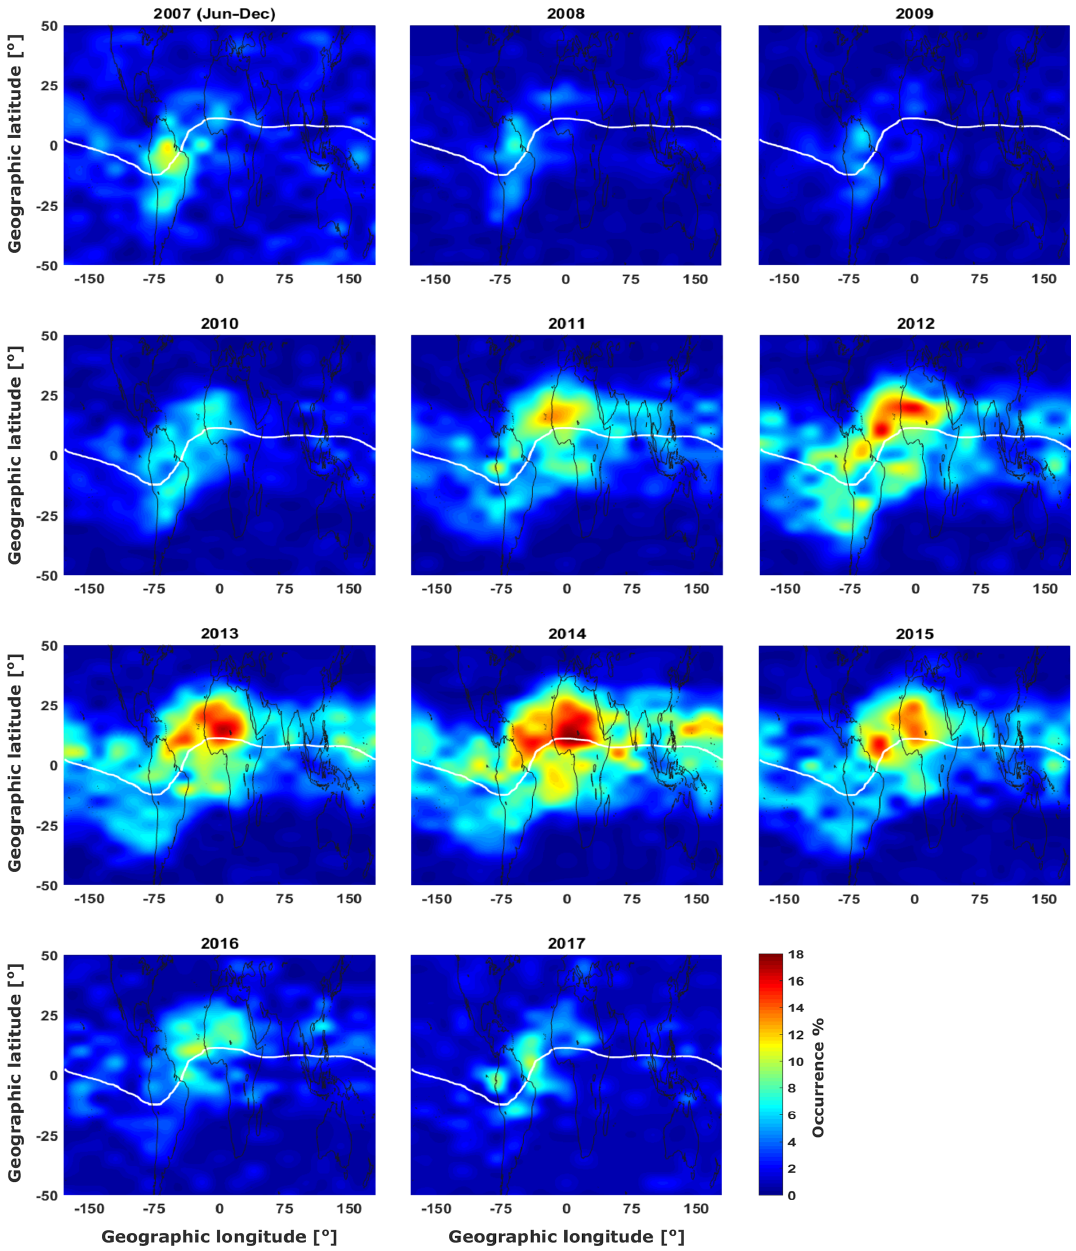
Figure 3. Geographical distribution of EPBs from mid-2007 to 2017 in a 5 ◦ latitudinal by 20 ◦ longitudinal grid. The white solid line depicts the geomagnetic